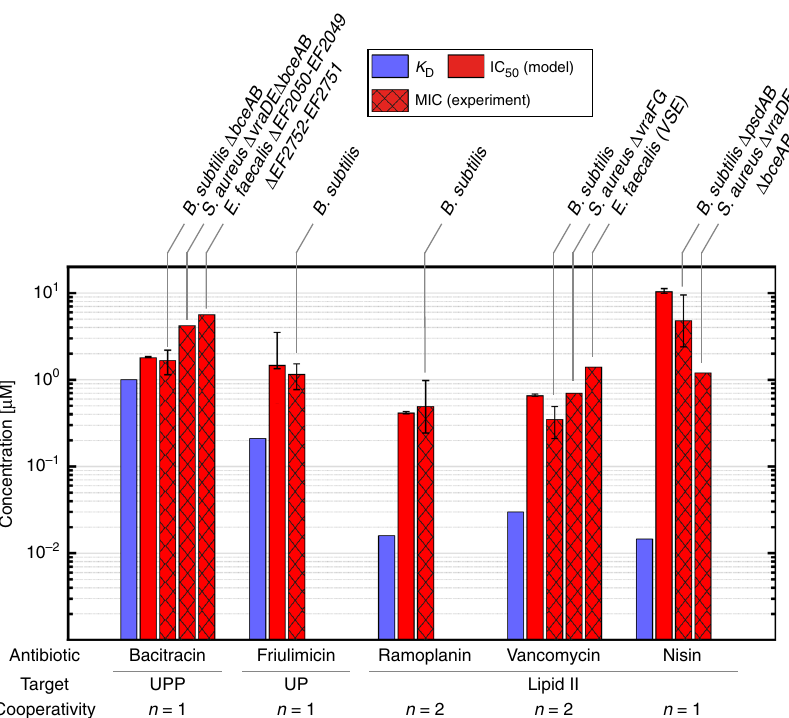
Fig. 5 Prediction of in vivo ef fi cacy for various cell wall antibiotics in diverse Gram-positive organisms. The mathematical model predicts the in vivo ef fi cacy (IC 50 , red solid bars) exclusively from the antibiotics in vitro dissociation constants ( K D , blue bars) and available information about the cooperativity in antibiotic-target-interaction. The model predictions are in good agreement with experimental data published for B. subtilis 9 – 11,49,58 , S. aureus 12,13 and E. faecalis 14,79 strains deleted for the known resistance determinants against the different antibiotics (MIC, red hashed bars), highlighting the universality of the theoretical model for various Gram-positive organisms. Error bars of literature MIC values either represent standard deviations from multiple measurements, when available in the original publications, or were derived from the increments of the serial dilution steps in the published MIC assays. Error bars for the model predictions of IC 50 values represent con fi dence intervals propagated from uncertainties in model parameters (see Supplementary Fig. 4 and 80